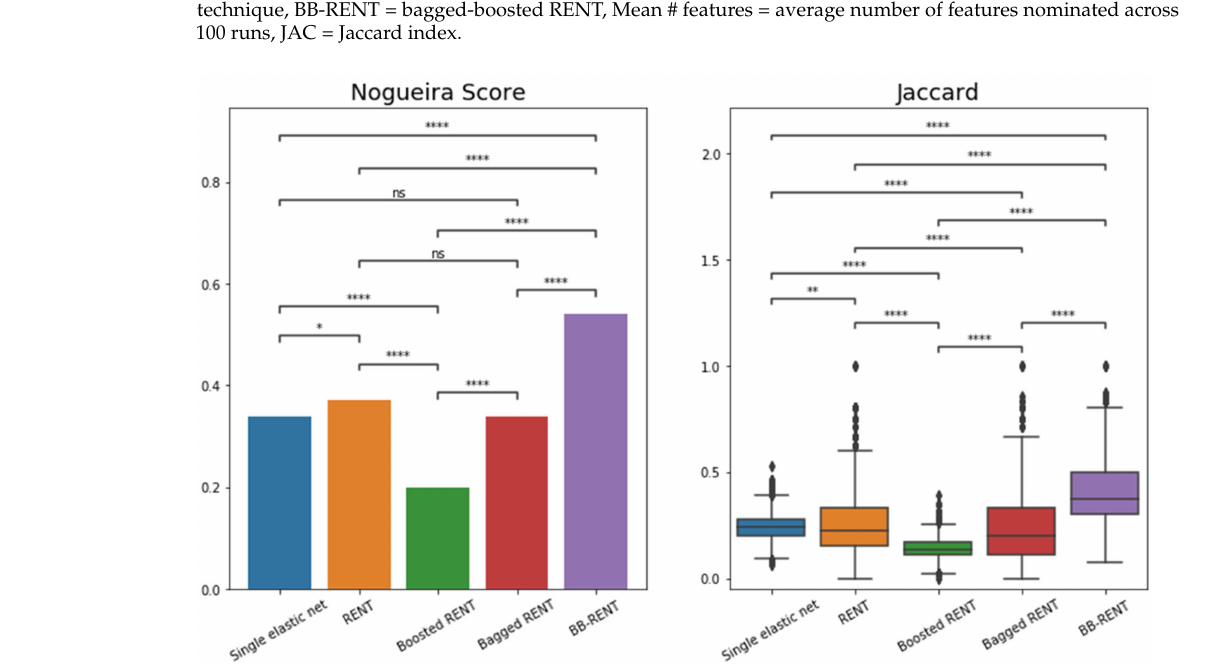
Figure 5. Graph of the feature selection stability results in terms of Nogueira score [31] and Jaccard index for the five feature selection methods. Of the original data, 80% was resampled 100 times, after which the five methods were used for feature selection. The Nogueira scores of each method were compared using the statistical test proposed in [31]. Jaccard indices (JAC) were computed from pairs of features nominated in those 100 runs and compared between different methods using independent sample t -tests. RENT = repeated elastic net technique, BB-RENT = bagged-boosted RENT, ns = not significant, * = p < 0.05, ** = p < 0.01, **** = p <